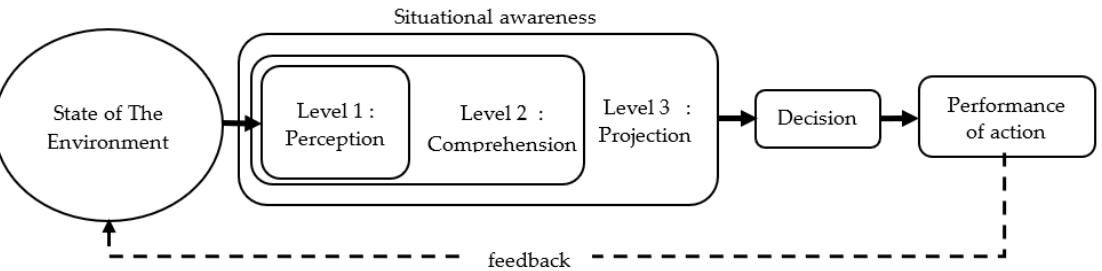
Figure 1. Three Levels of Situational Awareness (Jiang